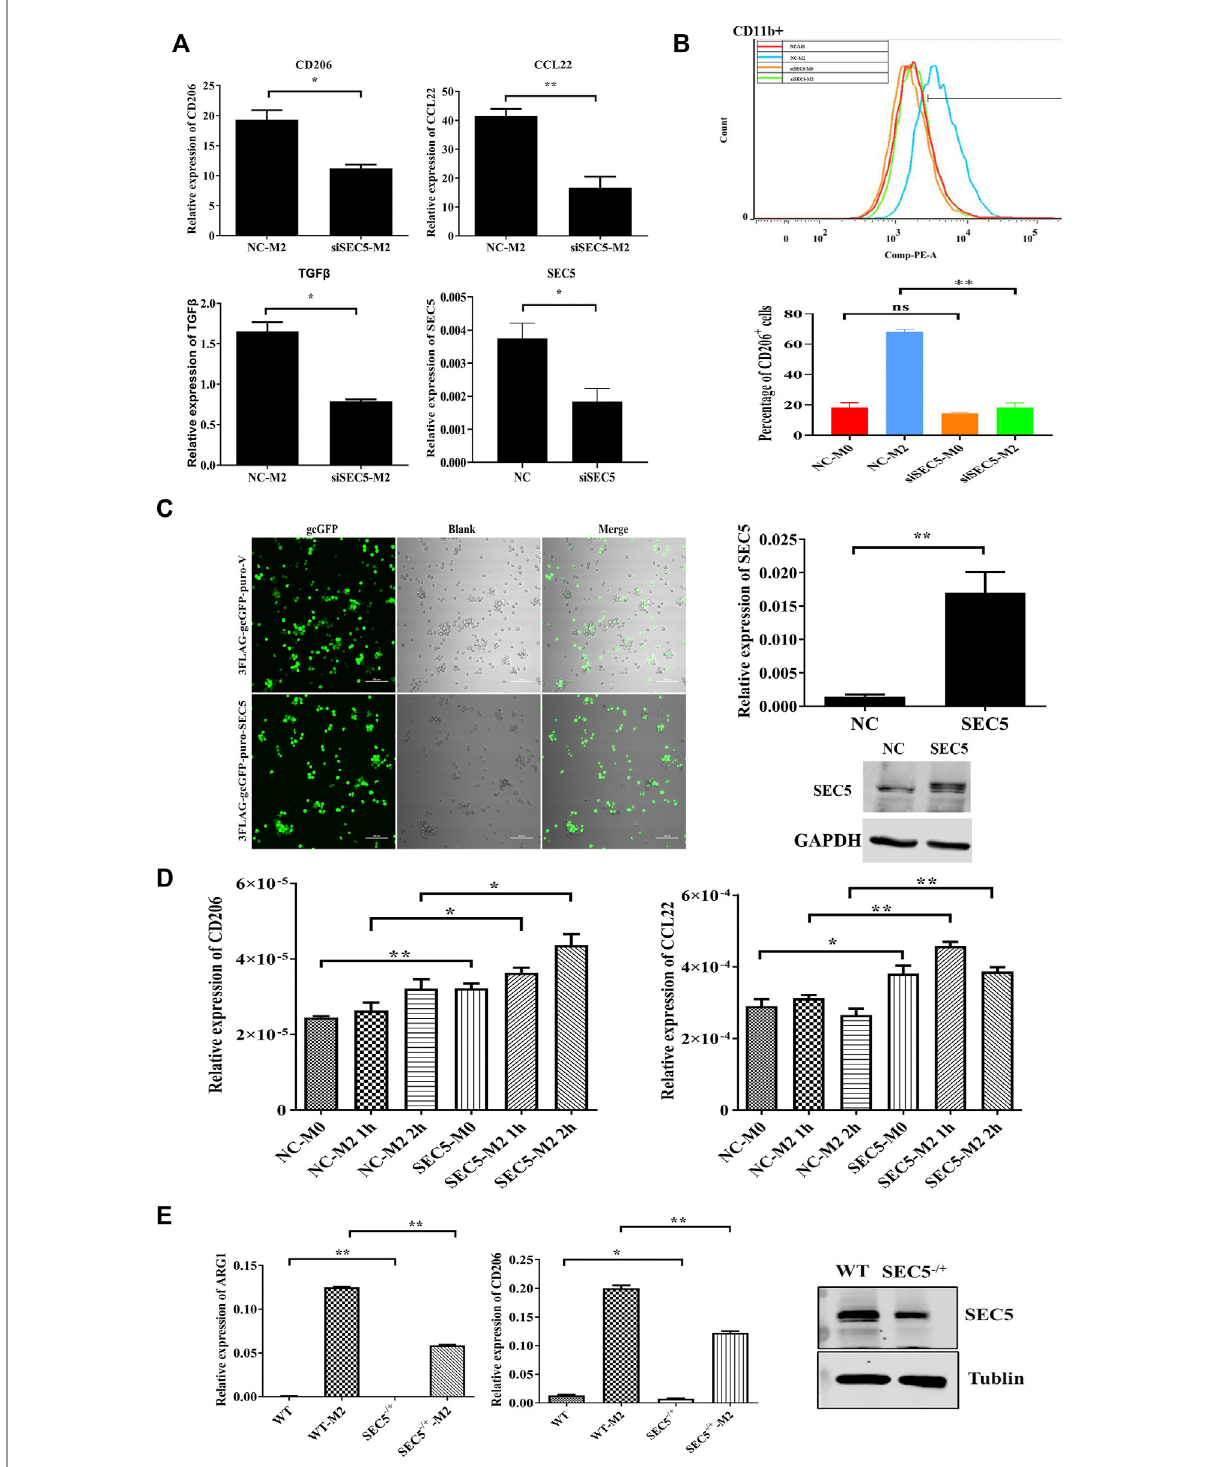
FIGURE 2 SEC5 promotes M2 polarization of macrophages induced by IL-4 and IL-13 in vitro . (A) Expression levels of M2 polarization markers (CD206, CCL22 andTGF β )determined byqRT – PCR inTHP-1 M ϕ sstimulated with IL-4 and IL-13 for theindicatedperiods.NC-M2:M0-M ϕ stransfected with thenegativecontrolandstimulatedwithIL-4+IL-3;siSEC5-M2:M0-M ϕ stransfectedwithSEC5-speci fi csiRNAandstimulatedwithIL-4+IL-3;NC: M0-M ϕ s transfected with the negative control; siSEC5: M0-M ϕ s transfected with SEC5-speci fi c siRNA. (B) Flow cytometry demonstrated the